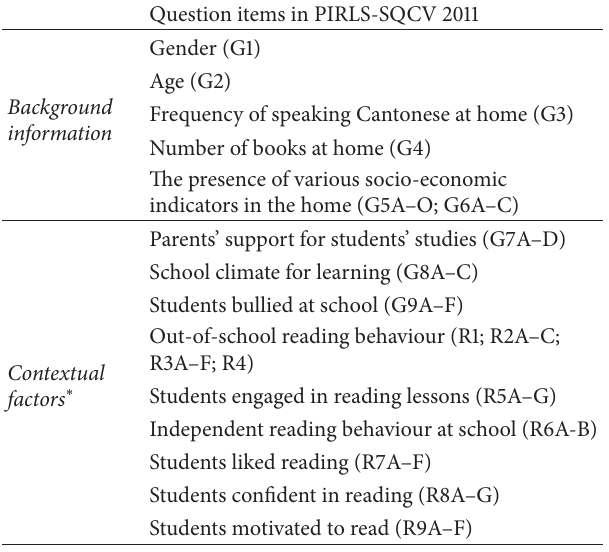
Table 1: Content of the PIRLS 2011 student questionnaire (PIRLS- SQCV